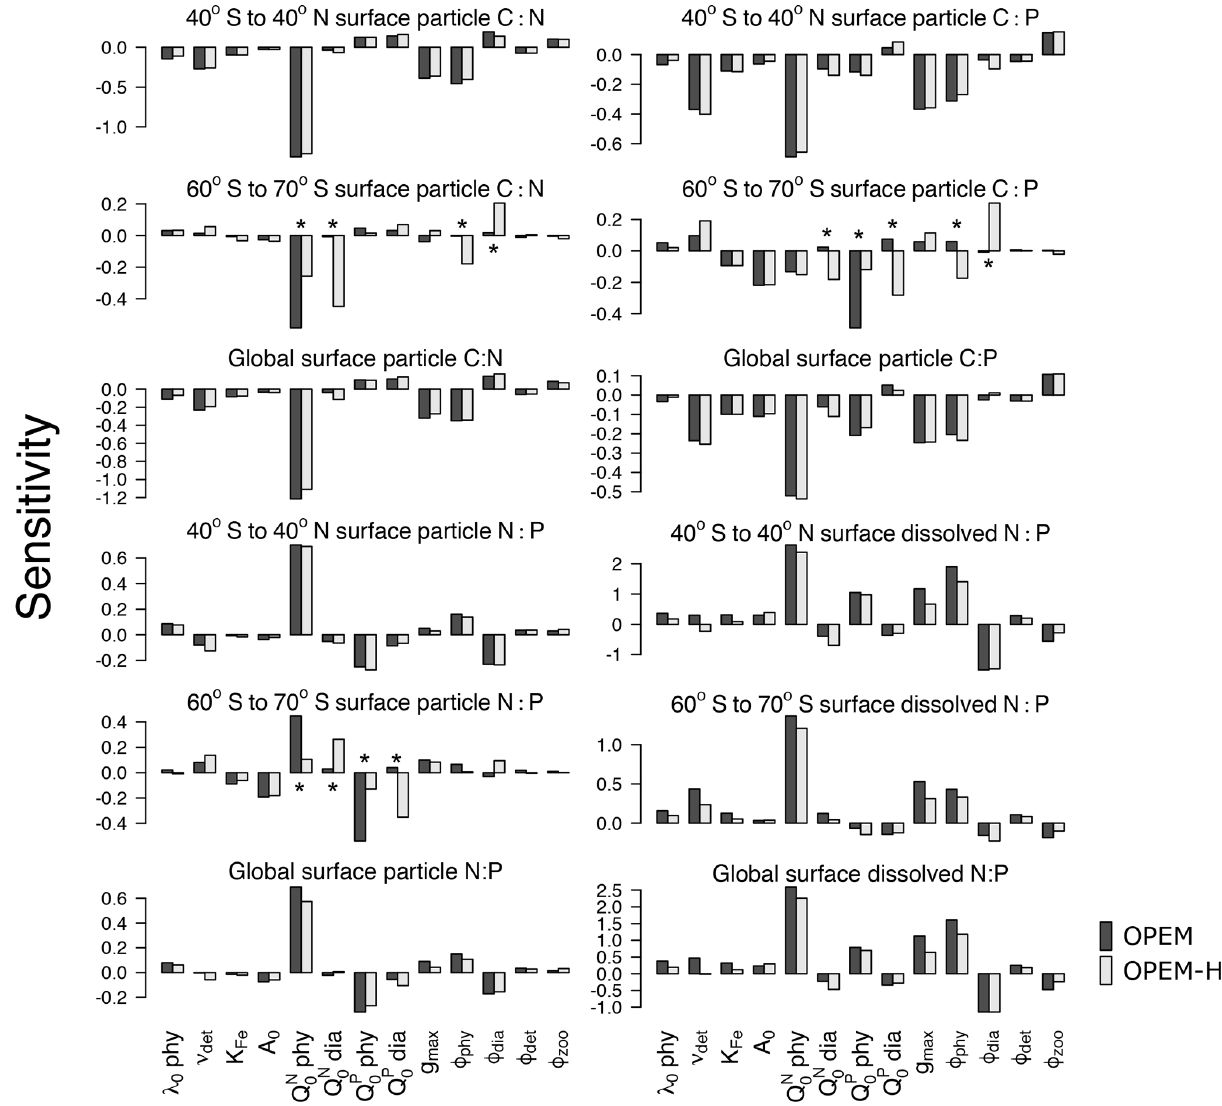
Figure 3. Parameter sensitivities of averaged surface (0–130m) particulate elemental C : N, C : P, and N : P ratios for different latitude bands (40 ◦ S to 40 ◦ N; 60 ◦ S to 70 ◦ S, and the global ocean). Asterisks indicate sensitivities that are very different between OPEM and OPEM-H. Note the different y -axis ranges in the different